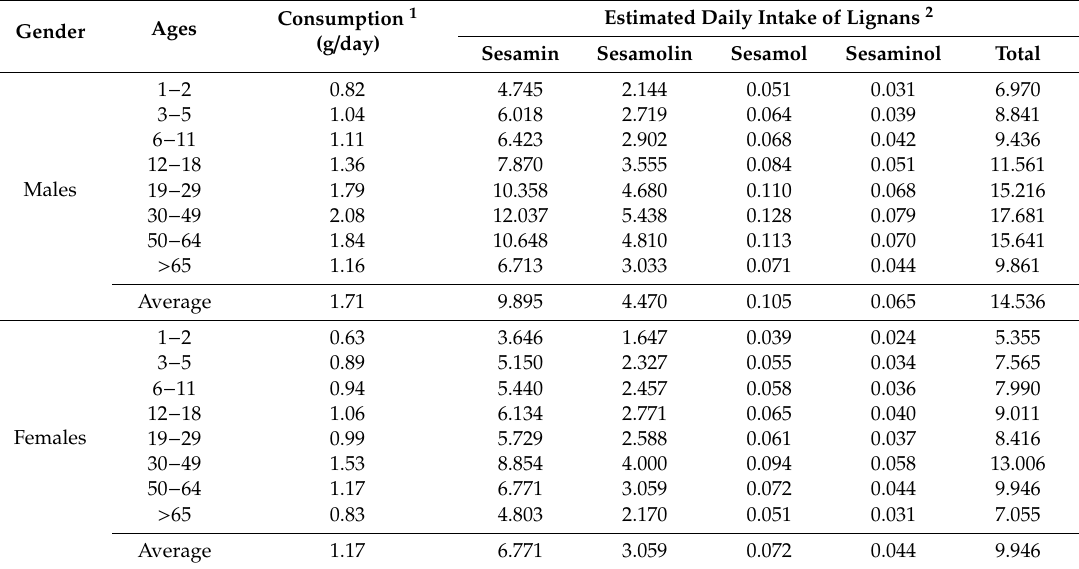
Table 6. Estimated daily intake (EDI) of lignans from sesame oil (mg / person / day). Consumption 1 Gender Ages (g /